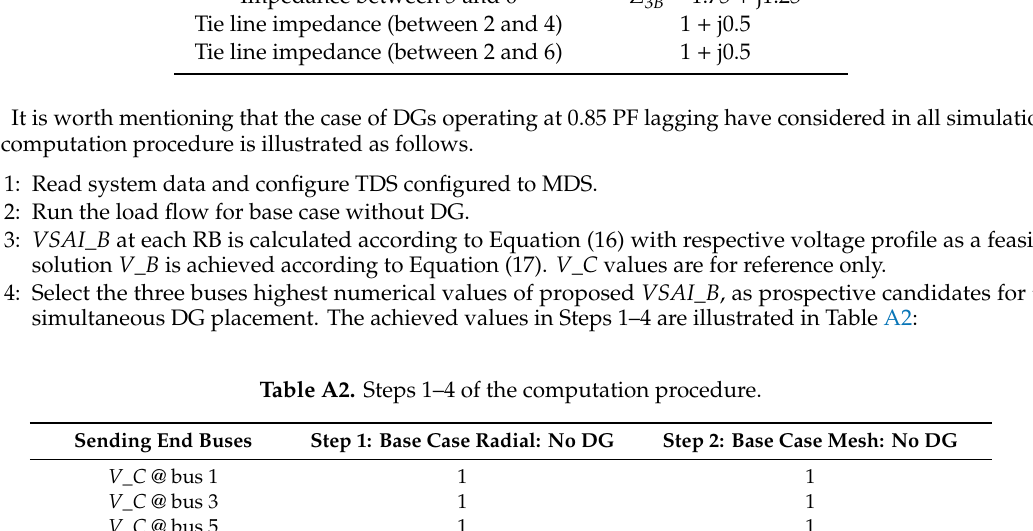
Table A2. Steps 1–4 of the computation procedure.